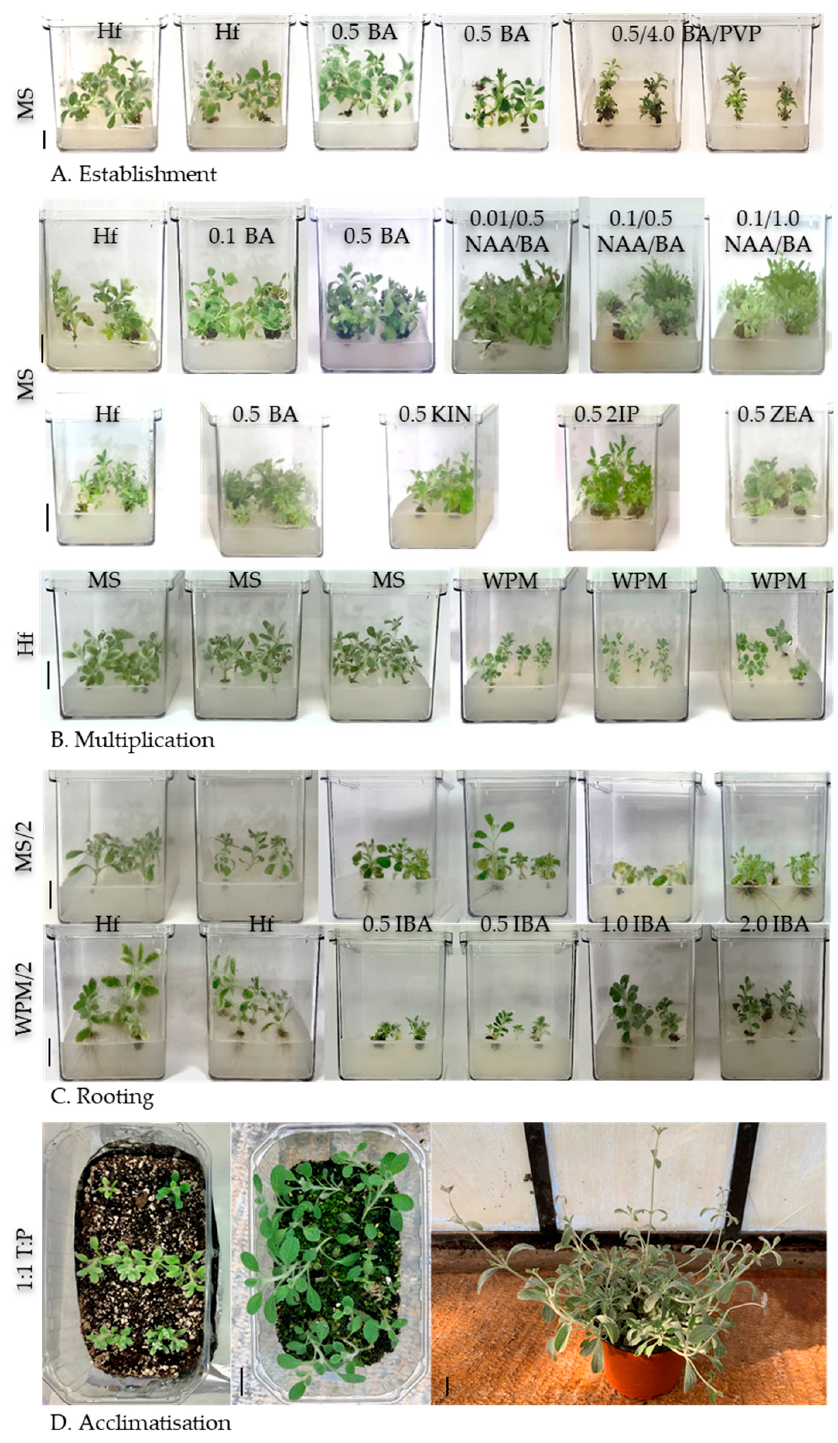
Figure 5. In vitro regeneration of Sideritis raeseri subsp. attica : ( A ) plantlets growing and root formation during the establishment of an initial culture of young seedlings after 40.0 days on various MS media; ( B ) multiplication stage and shoots forming on shoot explants after 40.0 days of culture on various MS media; ( C ) in vitro root formation after 20.0 days of culture on half-strength MS or WPM media (MS/2 or WPM/2, respectively) containing indole-3-butyric acid (IBA) at 0.0, 0.5, 1.0, or 2.0 mg L − 1 ; ( D ) plantlets during ex vitro acclimatisation on 1:1 T:P and two-month-old plants showing vigorous growth. Bars represent a length of 1 cm and the numbers represent the concentrations of phytohormones. (MS): Murashige and Skood medium; (Hf): hormone-free medium; (MS/2): half-strength